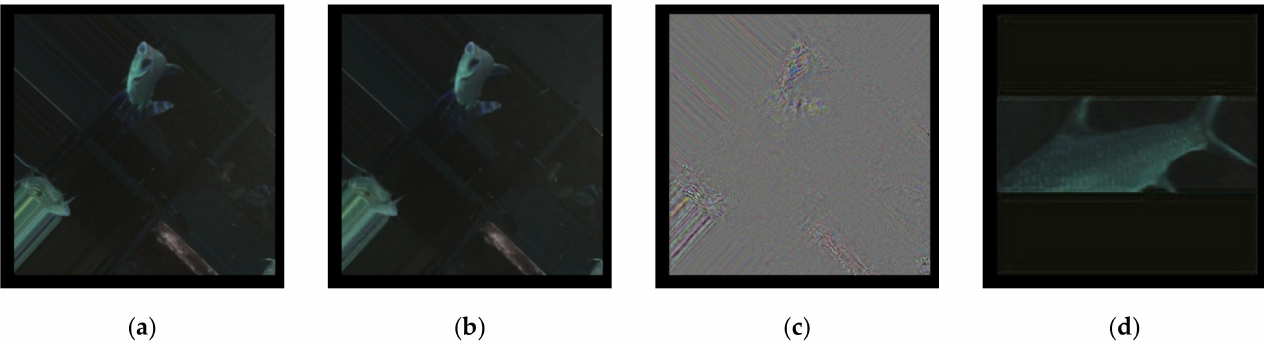
Figure 7. CNN full image autoencoder against cropped sample results: ( a ) source, ( b ) reconstructed, ( c ) difference, and ( d )